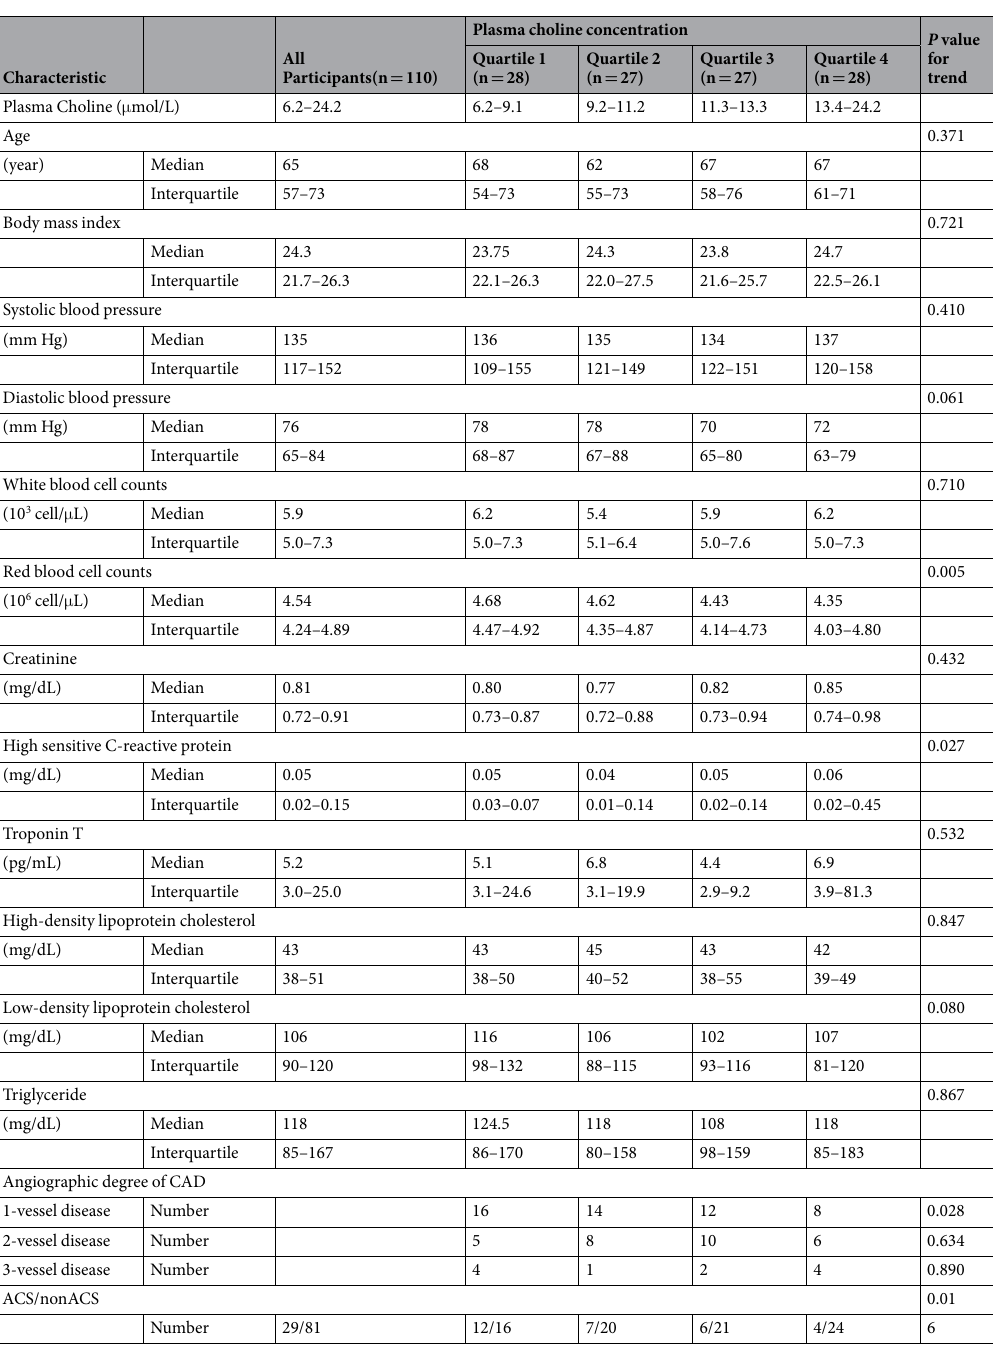
Table 2. Association between plasma choline quartile and risk factors for